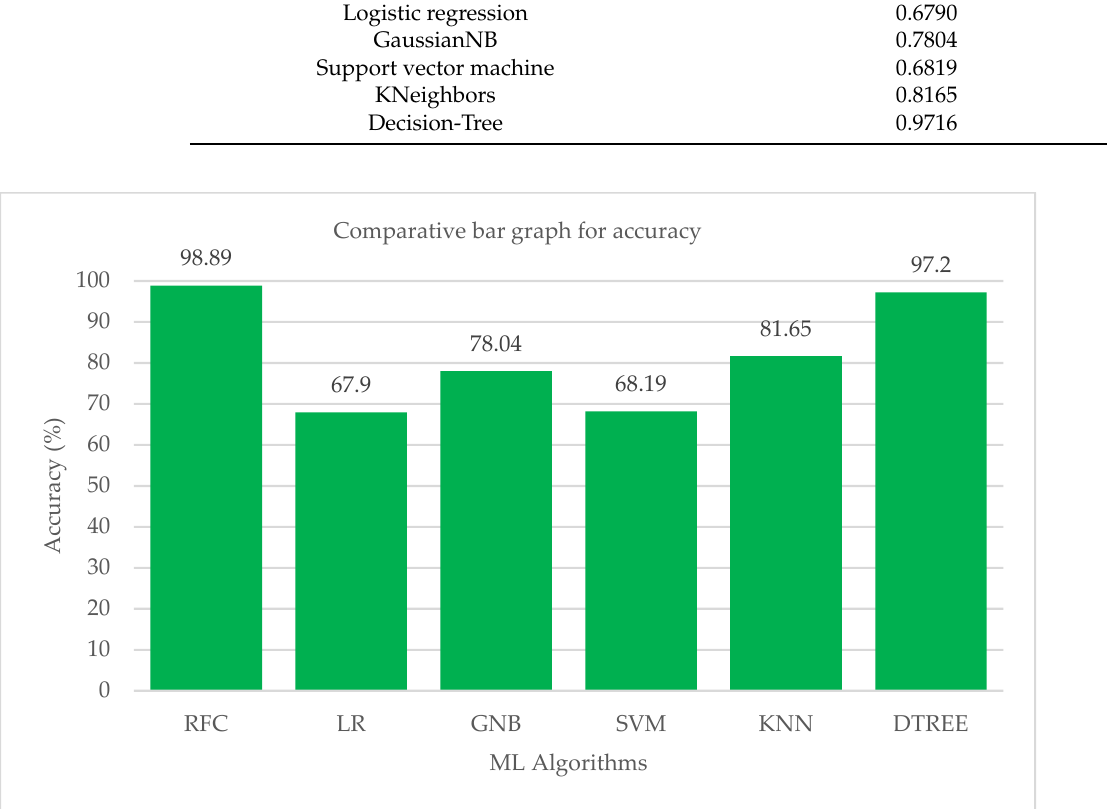
Figure 12. Bar chart visualization of accuracy comparison among different ML algorithms. Table 13. Accuracy of each ML algorithm.